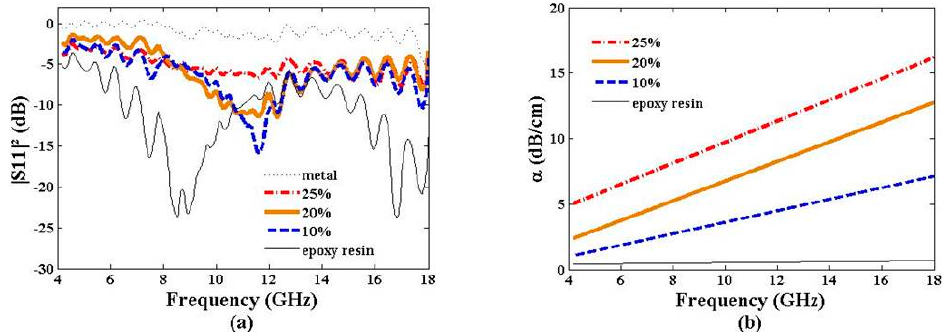
Figure 6. Reflected power |S 11 |² ( a ) and electromagnetic absorption α ( b ) vs. frequency of epoxy resin loaded with a 3-µm graphene particle size with various weight ratios. Pristine epoxy resin values are given for reference.